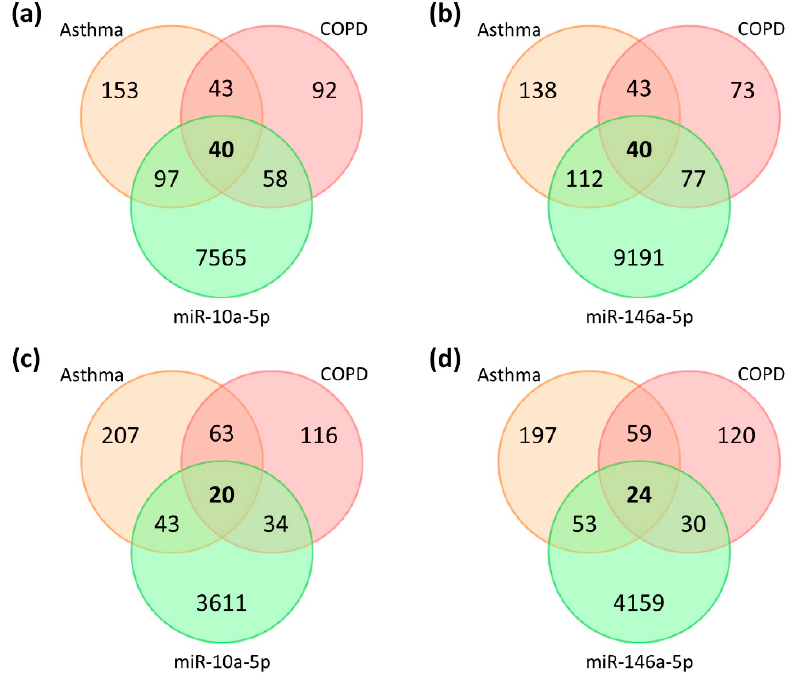
Figure 3. Venn diagrams showing the intersections of asthma-associated molecules, COPD-associated molecules, and the putative targets of miR-10a-5p ( a , c ) and miR-146a-5p ( b , d ) suggested by at least two ( a , b ) or four ( c , d ) databases in miRWalk 2.0.